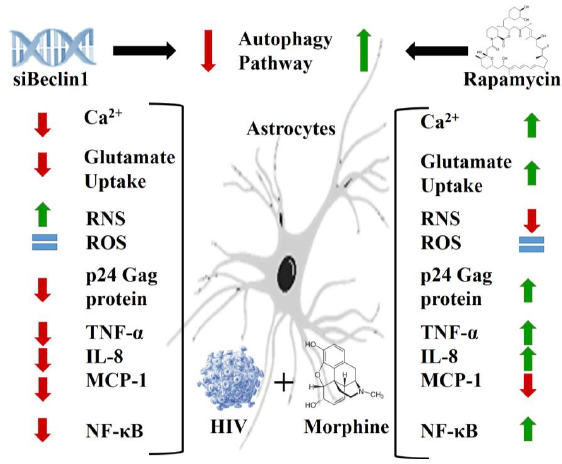
Figure 5. Proposed model for the role of autophagy in HIV-induced pathology and HIV-induced metabolic dysfunction in astrocytes in the context of opioid abuse. Green arrows indicate an induction, red arrows indicate a reduction, and blue equal symbols indicate no significant role of the respective molecules. Blocking the autophagy pathway with siBeclin1 significantly decreased HIV and morphine-induced intracellular calcium release and glutamate uptake with minimal changes in RNS and ROS production. Silencing with siBeclin1 significantly decreased HIV production and HIV and morphine-induced cytokines and chemokine secretion. On the contrary, increasing autophagy with rapamycin significantly increased HIV and morphine-induced intracellular calcium release, restored glutamate uptake and showed minimal decrease in RNS and ROS production. Rapamycin increased HIV replication, and HIV and morphine-induced TNF- α and IL -8 release. These effects correlate with the modulation of the NF- κB pathway by the autophagy pathway.